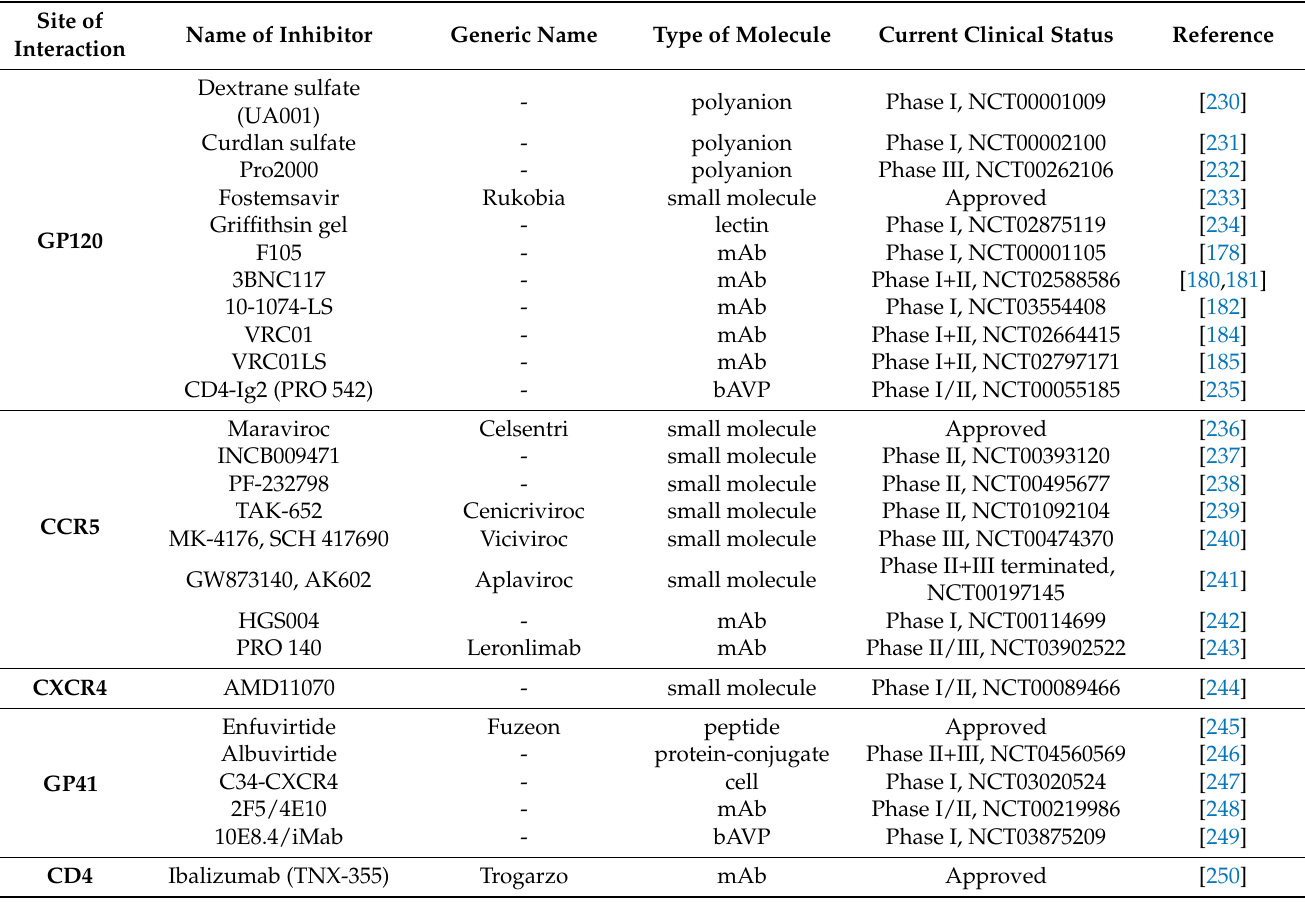
Table 1. List of entry inhibitors tested in clinical trials to